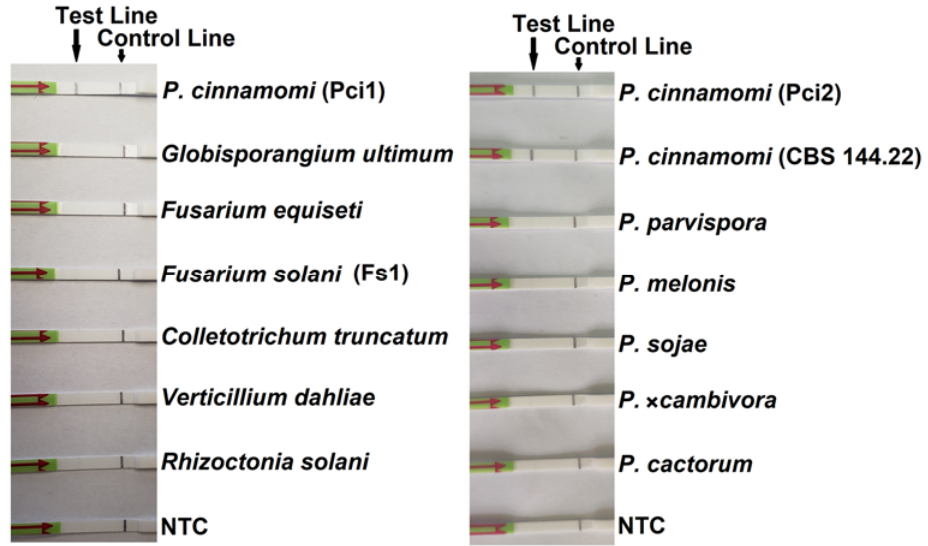
Figure 3. Detection results of the recombinase polymerase amplification ‐ lateral flow dipstick assay